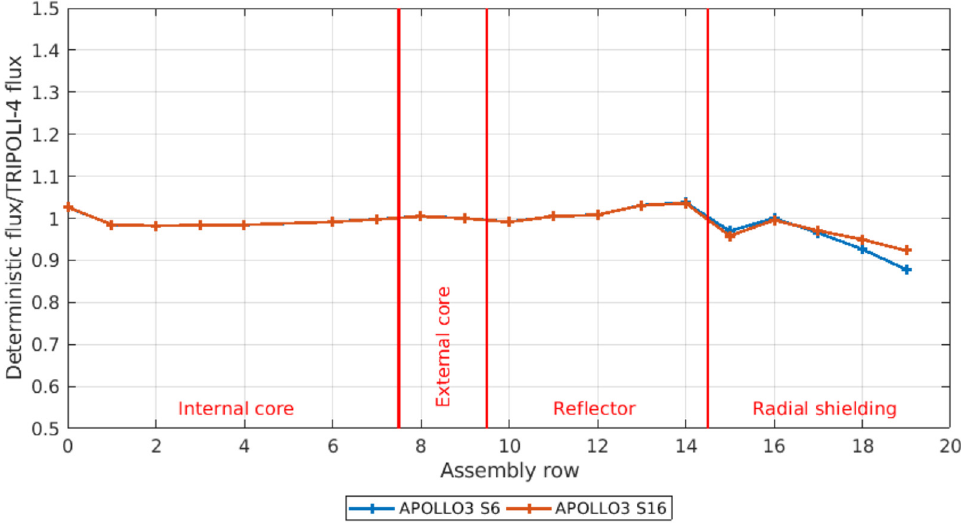
Fig. 18. Impact of the number of angular directions on the fl uxes calculated in the shielding of ASTRID. Table 2. Calculation cost and biases obtained with each deterministic